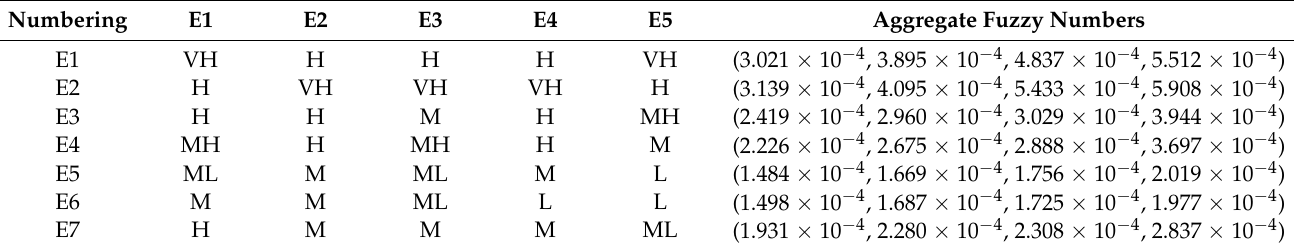
Table 11. Failure judgments of experts of basic